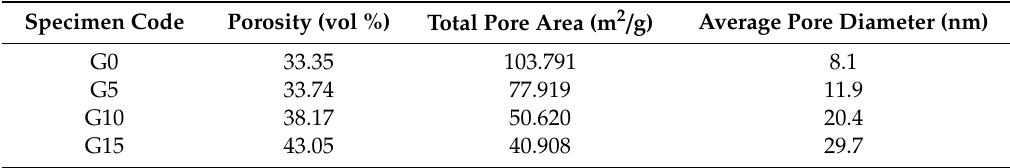
Figure 8. Pore size distribution on the 28th day. Table 3. Pore characteristics on the 28th